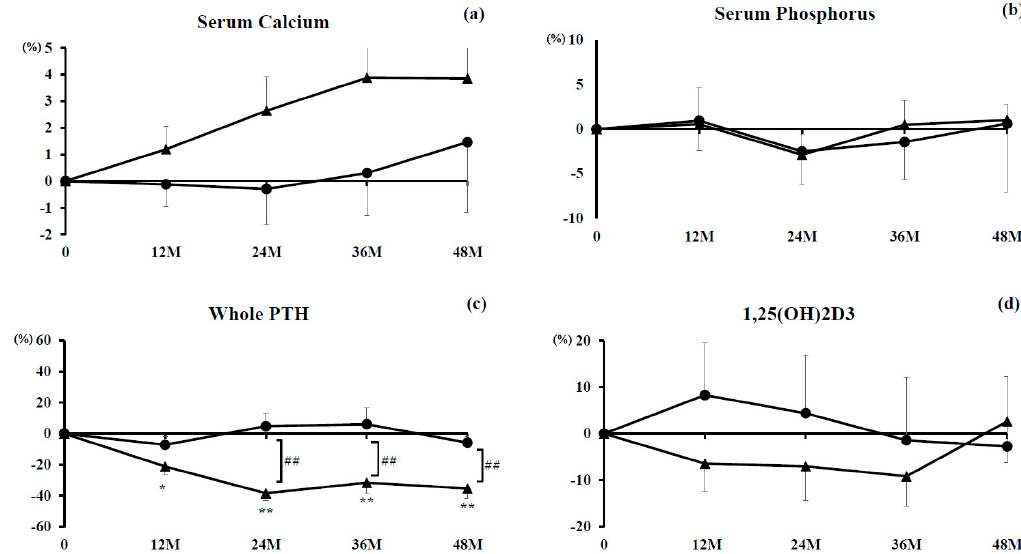
Figure 1. Percent changes in concentrations of serum albumin-corrected calcium ( a ); phosphorus ( b ); whole parathyroid hormone (PTH) ( c ); and 1,25(OH) 2 D 3 ( d ). Closed circles indicate the denosumab monotherapy group and closed triangles indicate the combination group. Single ( P < 0.05) and double ( P < 0.01) asterisks denote significant differences compared with pretreatment values. Double hashtags denote a significant difference ( P < 0.01) between the denosumab monotherapy and combination groups at indicated time points.